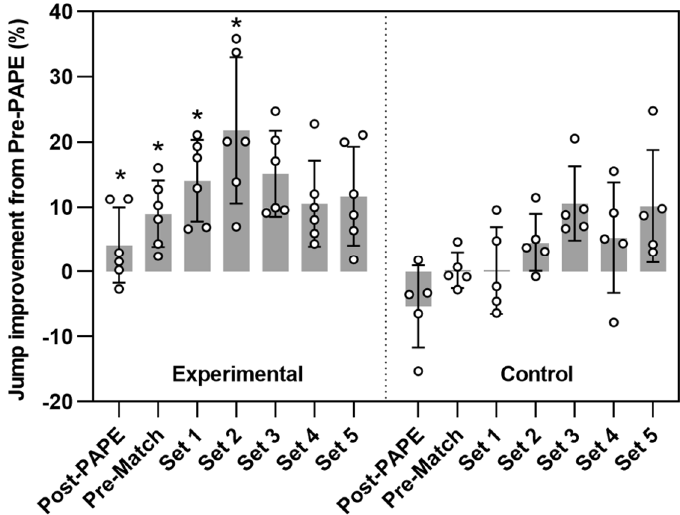
Figure 2. Comparison of the improvement values from Pre-PAPE performance expressed as percentage. * Significant difference between experimental and control groups at the time points: pre-PAPE, Pre-match and Set 1, Set 2, Set 3, Set 4, and Set 5. Bars, whiskers, and dots represent mean, standard deviation and individual values, respectively.